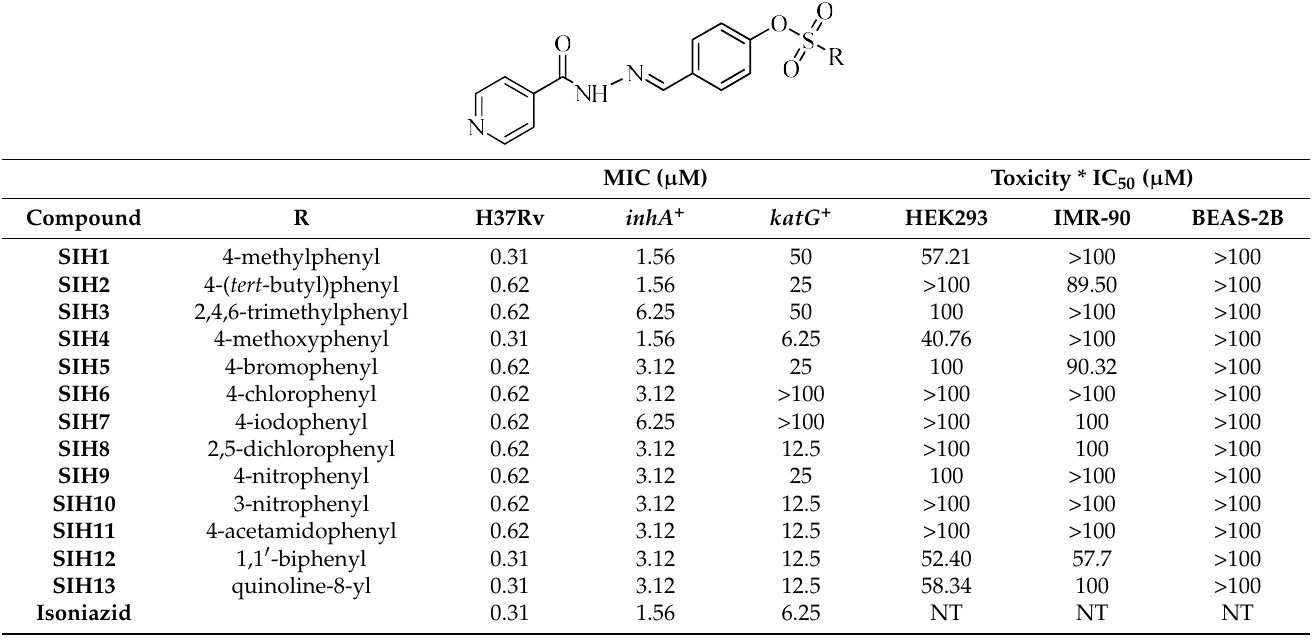
Table 1. MIC values against Mtb H37Rv and INH-resistant clinical isolates, and cytotoxicity data of SIH1–SIH13 .